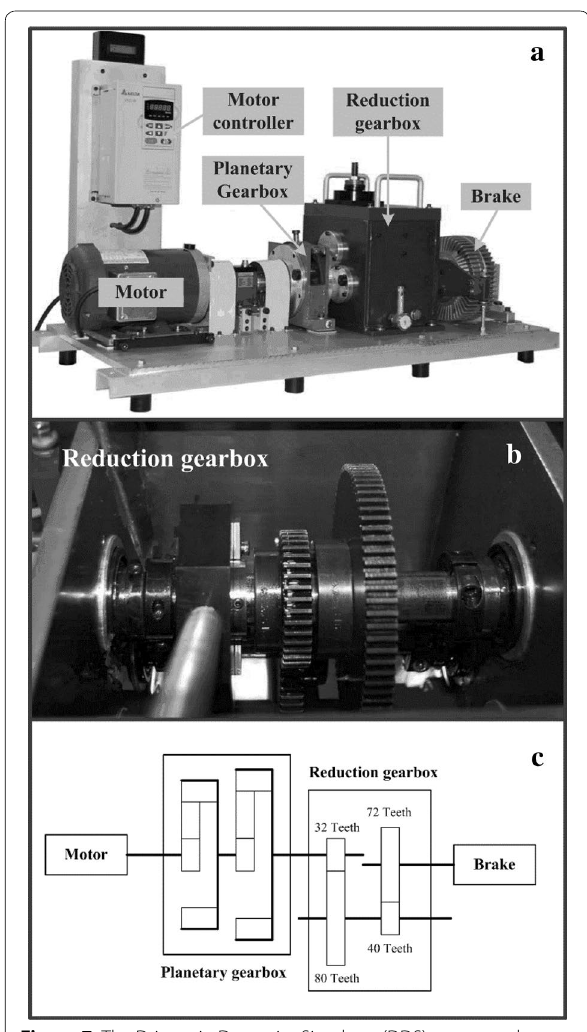
Figure 7 The Drivetrain Dynamics Simulator (DDS) system: a the whole physical map of DDS system; b the internal structure image of DDS system; c transmission ratio of reduction gearbox